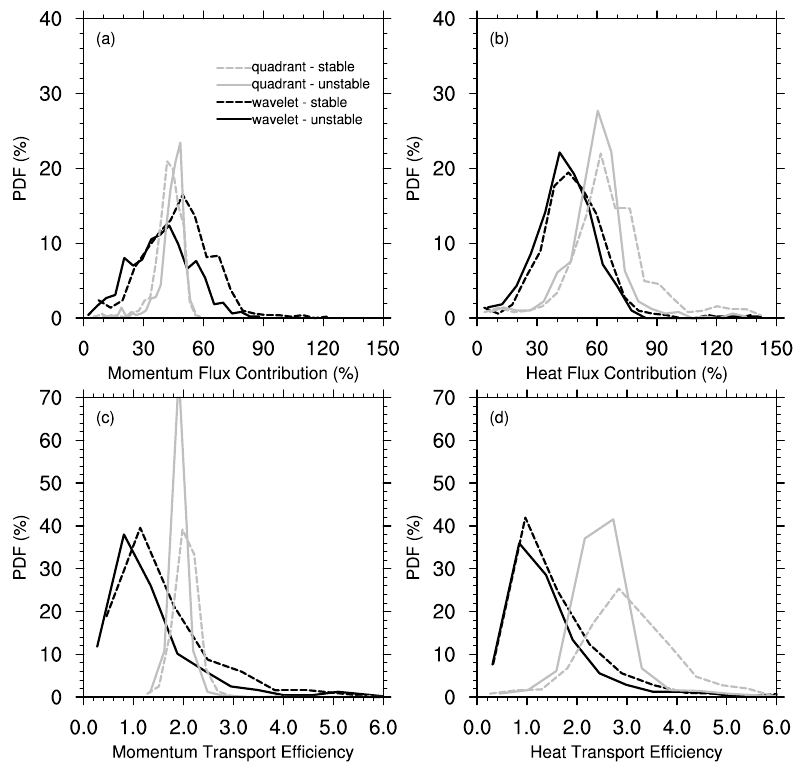
Figure 7. Probability distribution function of percentage of (a) contribution to kinematic 833 Fig. 7. Probability distribution function of (a) percent contribution to kinematic momentum flux, (b) percent contribution to kinematic heat flux, (c) momentum transport efficiency, and (d) heat transport efficiency for the Q-H (gray lines) and wavelet (black lines) methods under momentum flux and (b) contribution to kinematic heat flux, (c) momentum transport 834 stable (dashed) and unstable (solid lines) efficiency, and (d) heat transport efficiency for the Q-­‐H (gray lines), and wavelet methods 835 (black lines) under stable (dashed) and unstable (solid lines) conditions. 836 837